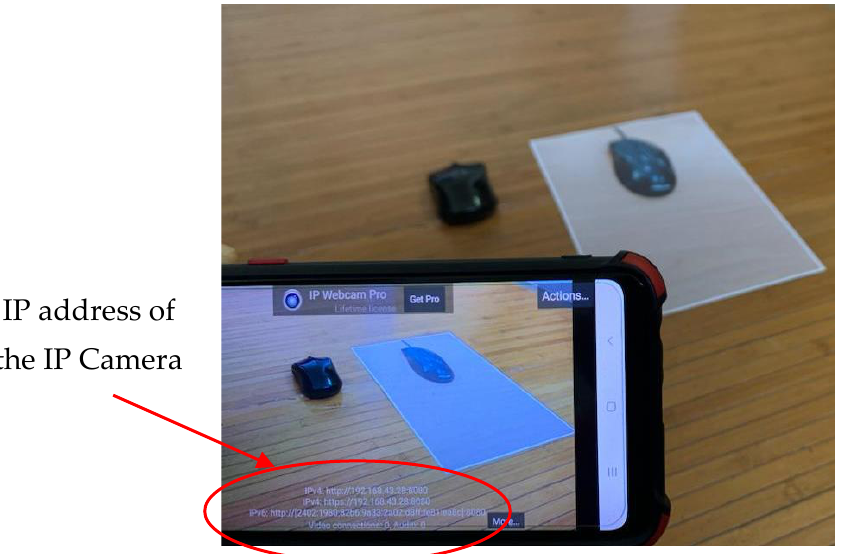
Figure 18. IP address of the IP camera displays on the mobile device (iPhone).